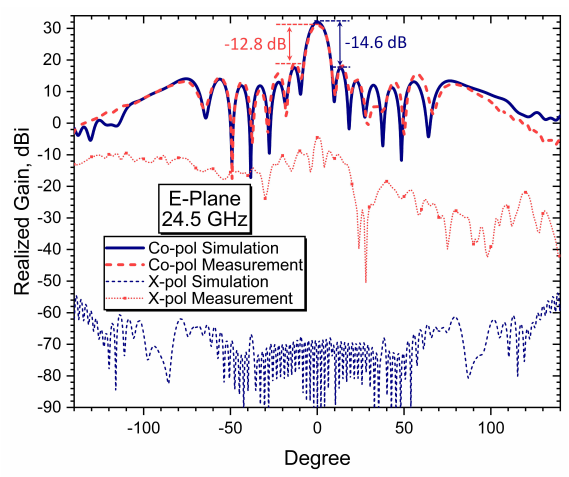
FIGURE 6. Simulated and measured E-plane radiation patterns of the antenna at 24.5 GHz.